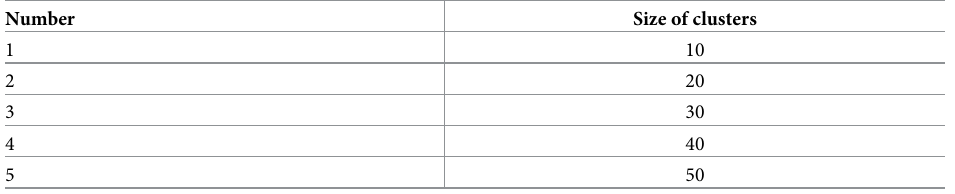
Table 6. Sum of Squares method for k-means